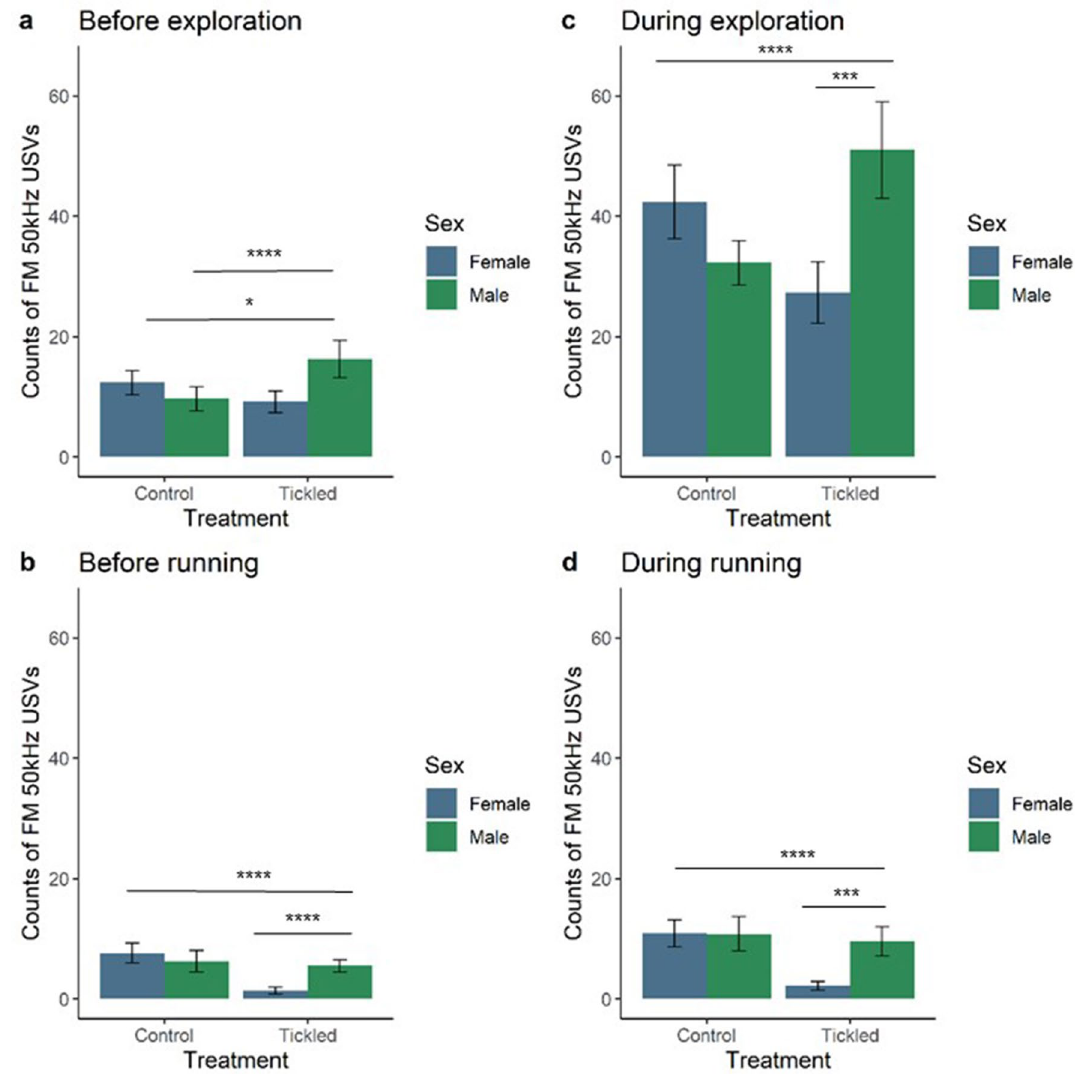
Figure 4. Frequency-modulated (FM) ultrasonic vocalisations (USVs) paired with explorations and running in tickled compared to control rats. Estimated marginal means ± 5% CI of FM 50 kHz USVs produced in the one second before exploration ( a ) and running ( b ) ‘non play-related’ behaviours, and FM 50 kHz USVs produced during exploration ( c ) and running ( d ) ‘non play-related’ behaviours. Female rats (blue) and male rats (green). n = 16/group. *denotes p ≤ 0.05; **denotes p ≤ 0.01; ***denotes p ≤ 0.001; **** denotes p ≤ 0.0001 for significant pairwise